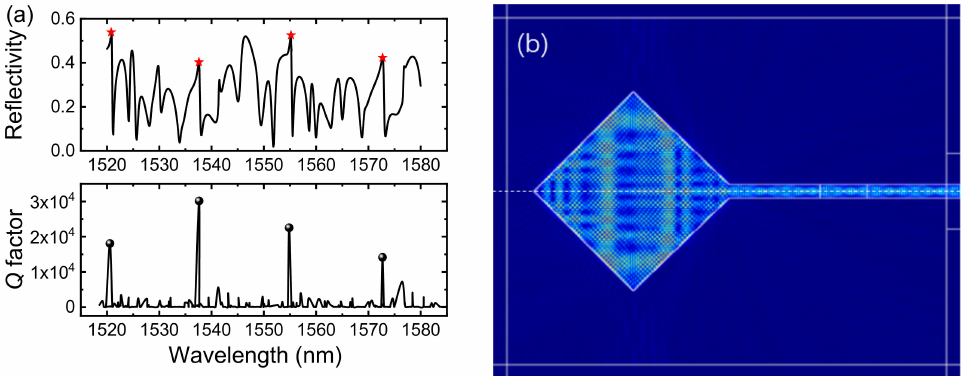
Figure 2. ( a ) The reflection spectrum and quality factors ( Q ) of HSRRL, and ( b ) mode intensity profiles of H z at 1537.6